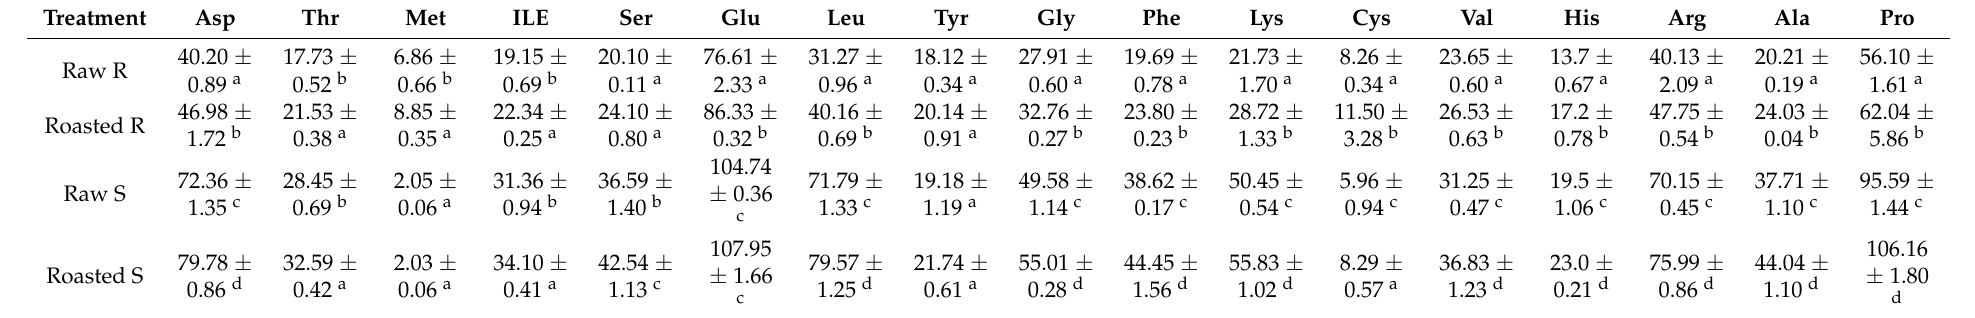
Table 3. Amino acid (mg/g, dw) profile of raw and roasted N. arvensis (R) and N. sativa